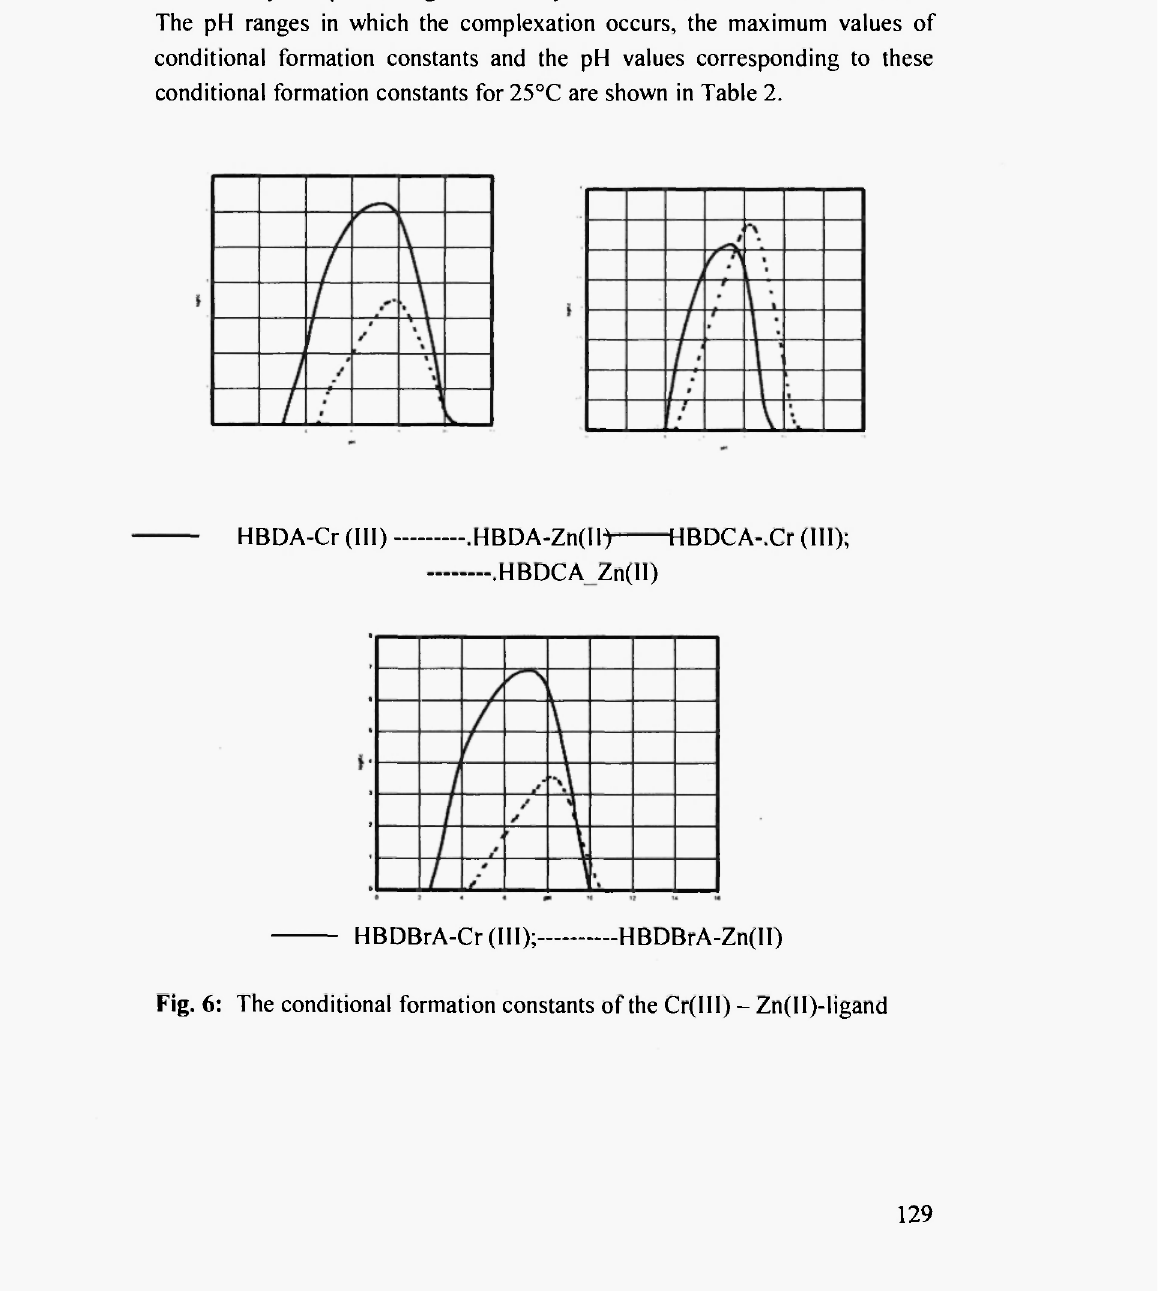
Fig. 6: The conditional formation constants of the Cr(III) - Zn(II)-ligand